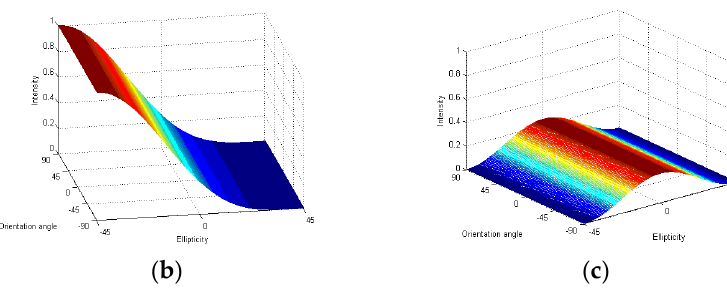
Figure 3. ( a ) Dihedral, ( b ) co-pol and ( c ) cross-pol polarimetric signatures characterizing scattering.